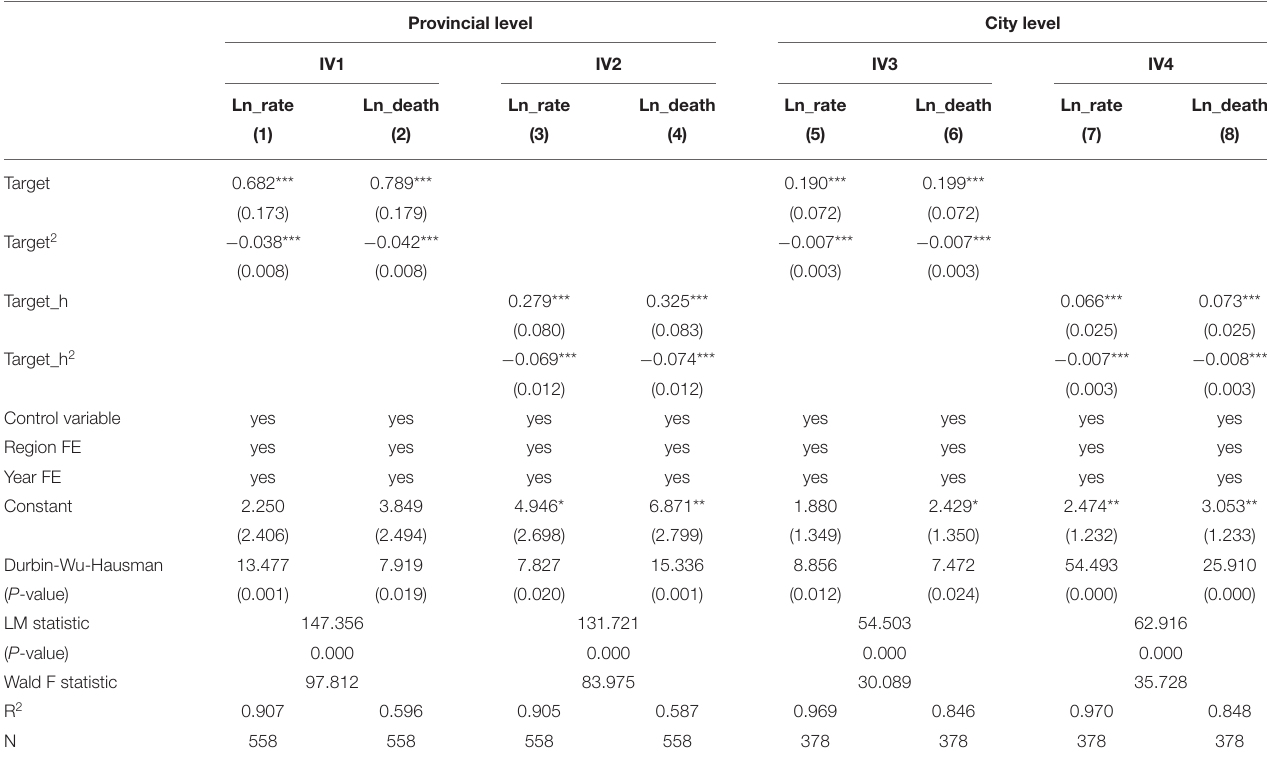
TABLE 3 | Regression results of the instrumental variable method.